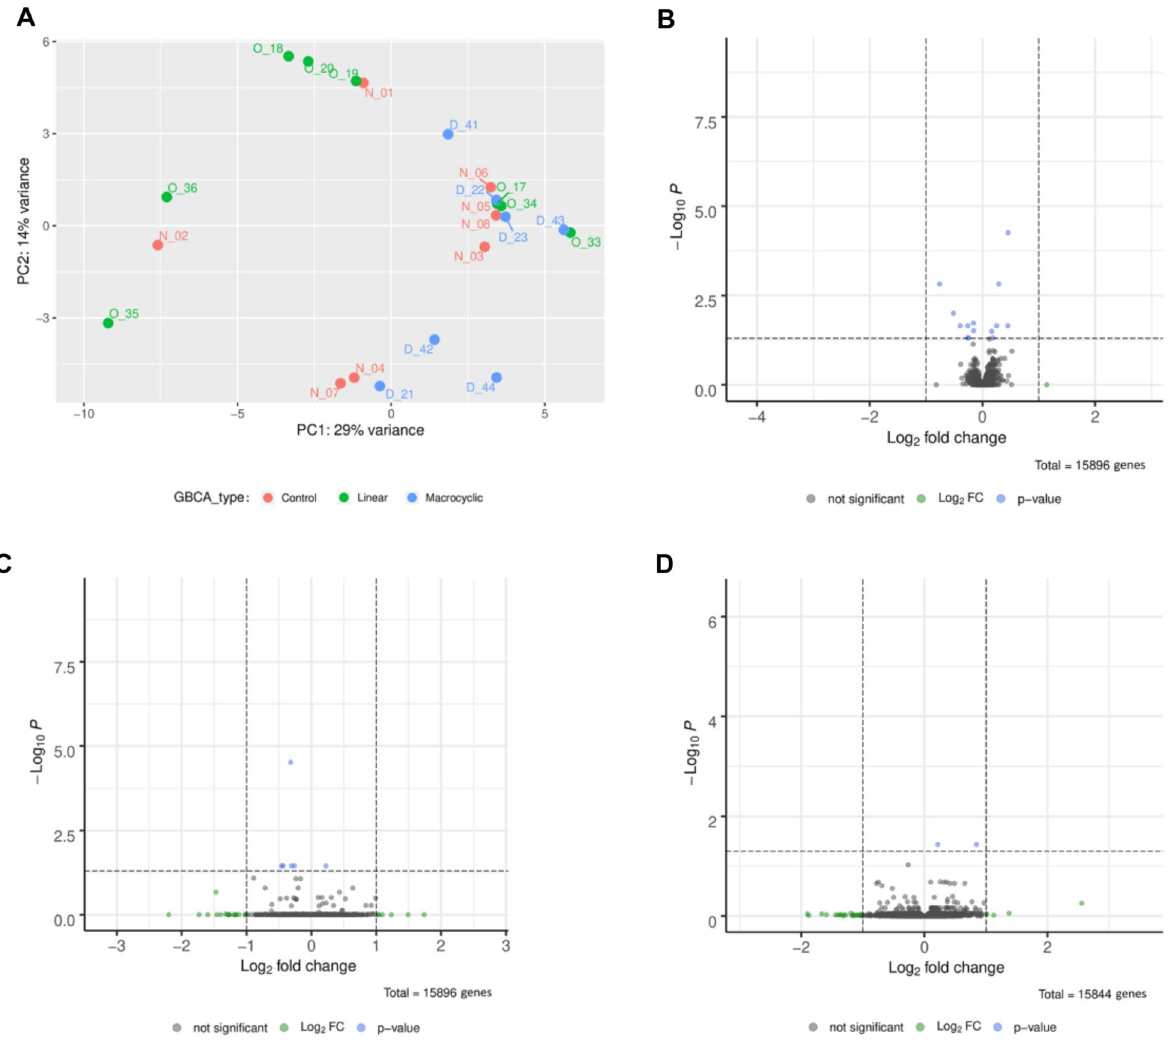
Figure 2. Unsupervised and supervised analysis of gene expression profiles. Principal component analysis of gene expression profiles ( A ) O = linear GBCA; D = macrocyclic GBCA; N = control treatment. Volcano plots ( B – D ) of all reference mouse genes differentially expressed between linear GBCA and control treatment ( B ), macrocyclic GBCA and control treatment ( C ) and linear GBCA and macrocyclic GBCA treatment ( D ). Total = number of genes identified in all 16 samples of a comparison. p -value (blue) = Gene with significant p -value; Log2FC (green) = Gene with |L2FC|≥ 1; not significant (grey) = Gene with insignificant p -value and |L2FC|<